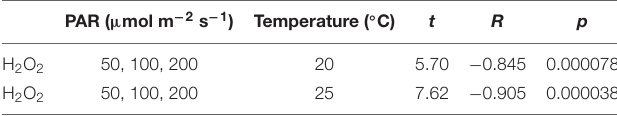
TABLE 3 | Relationship between PAR and H 2 O 2 concentration in 30 days experiment.